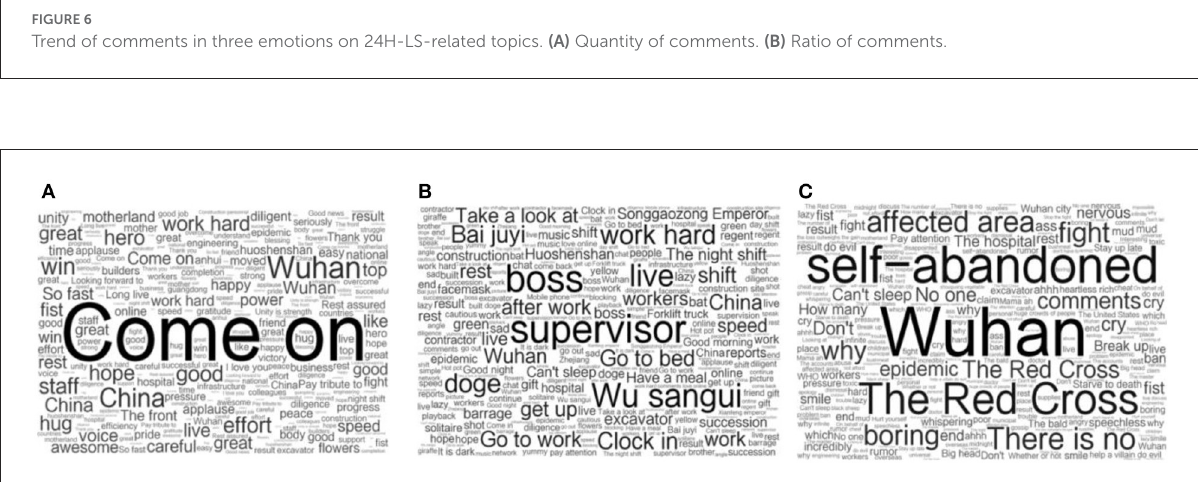
FIGURE7 Cloud map of keywords in comments with different emotional tendencies. (A) Comments with positive emotions. (B) Comments with neutral emotions. (C) Comments with negative